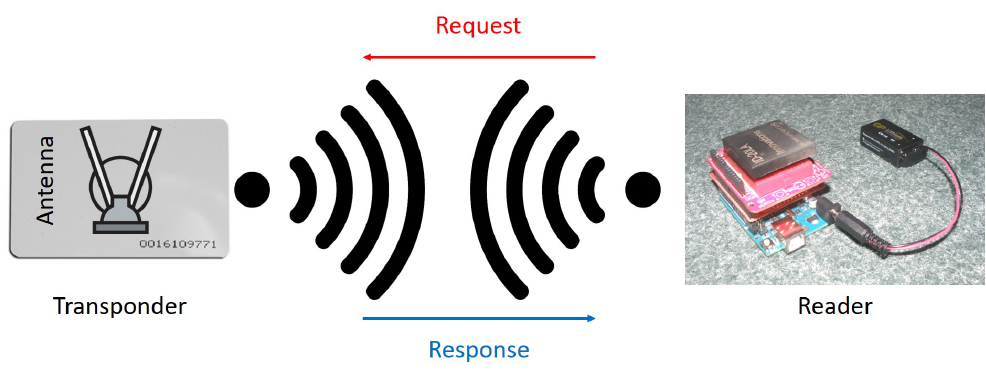
Figure 3. Principle of passive radio frequency identification (RFID) function. The reader can send the received Electronic Production Code (EPC) to a computer or process it